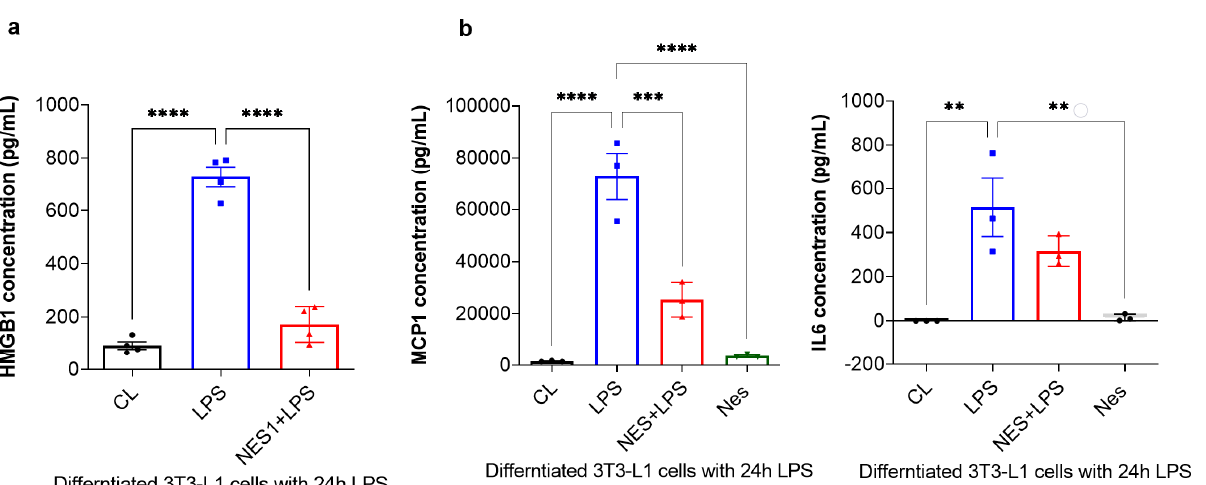
Figure 4. Nesfatin-1 inhibits HMGB1, as well as MCP-1 and IL6 secretion. ( a ) HMGB1 secreted levels were measured by Elisa and the experiments were repeated in four independent cultures. One-way ANOVA; **** p < 0.0001. ( b ) MCP-1 and IL6 secreted levels were measured by Bioplex-200 multiplex immunoassays. The experiments were repeated in three independent cultures. One-way ANOVA; ** p < 0.01; *** p < 0.001, **** p < 0.0001.